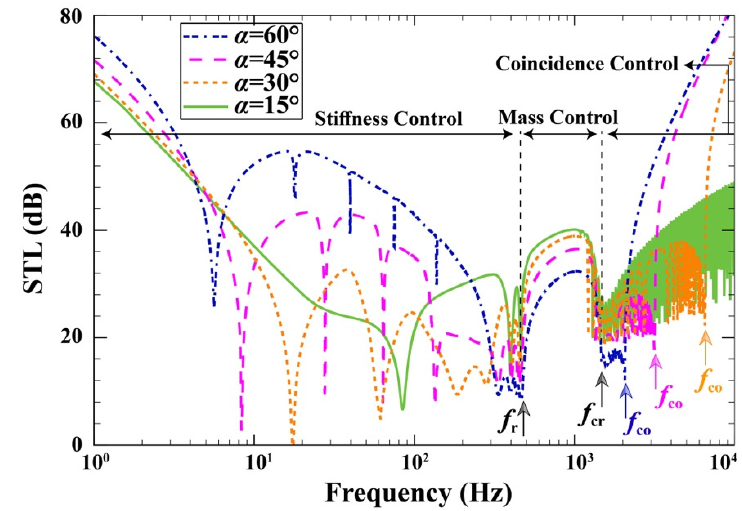
Figure 5. STL curves for different elevation angles.